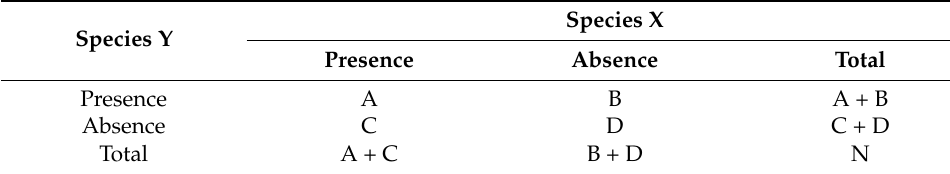
Table 1. Contingency table of the phi coefficients. Species